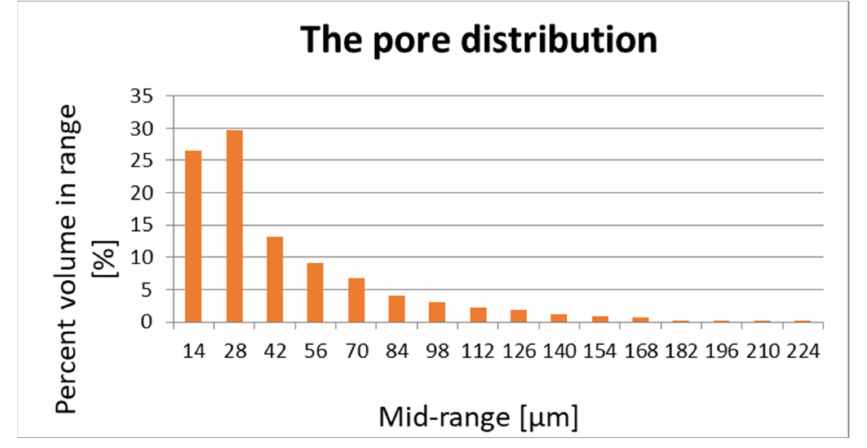
Figure 1. Pore distribution of sample